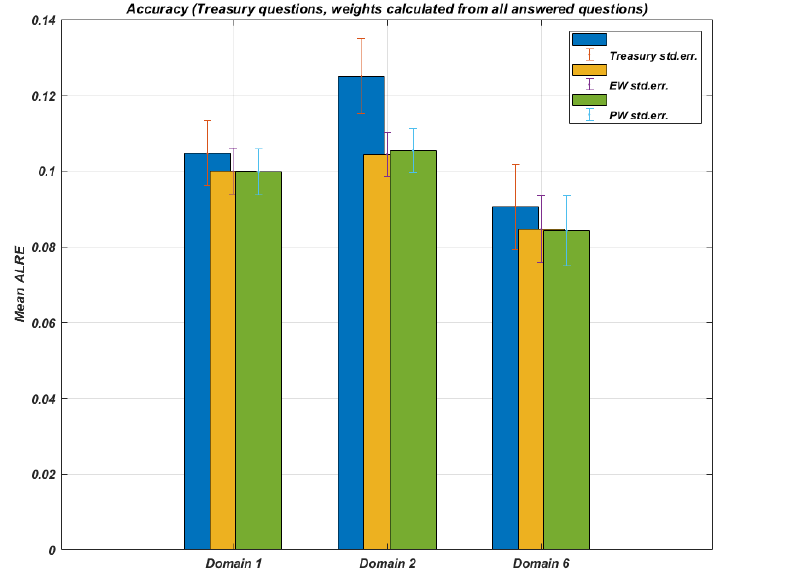
Figure 7. Accuracy of Treasury forecasts compared to EW and PW forecasts, with weights calculated based on all questions answered by experts. The figure shows the mean ALRE of forecasts and standard error intervals. Domain 1 = Australian economic growth, Domain 2 = Australian Macro- economic indicators, Domain 6 = OECD and other country economic growth.